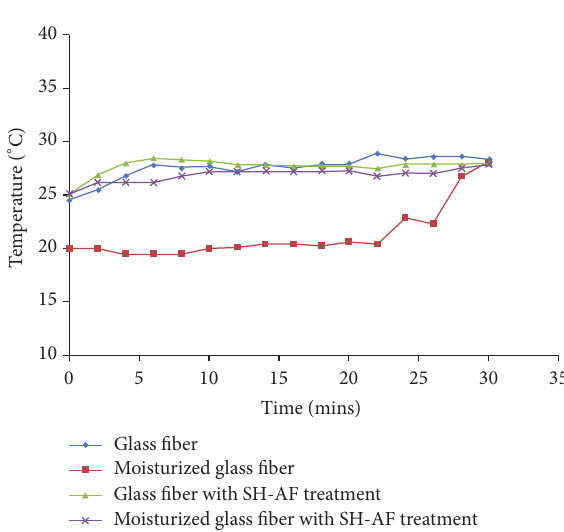
Figure 7: Surface temperature change in glass fiber before and after